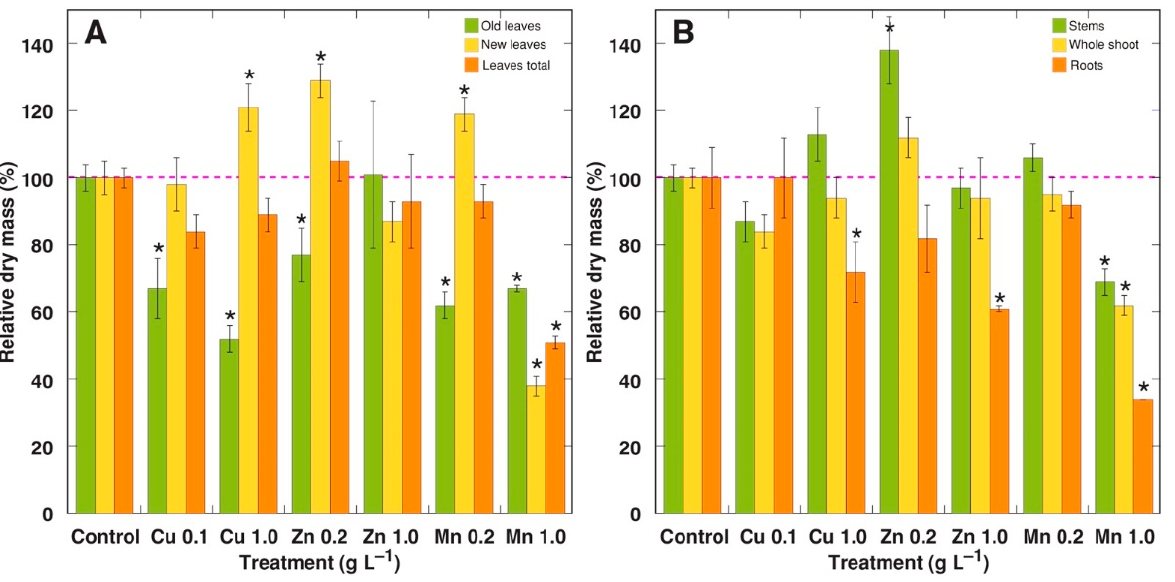
Figure 2. Effect of treatment with different concentrations of Cu, Zn, and Mn on relative dry mass of different parts ( A : old leaves, new leaves, leaves total; B : stems, whole shoot, roots) of H. maximum plants (Experiment 1). Data are means ± SE from 5 replicates. Note: * indicates statistically significant difference from the respective control ( p < 0.05).